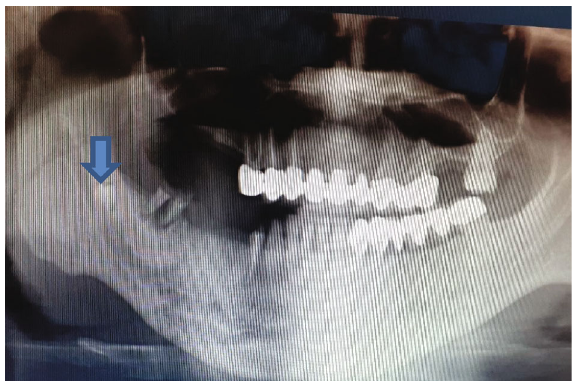
Figure 1: Ectopic premolar tooth seen at